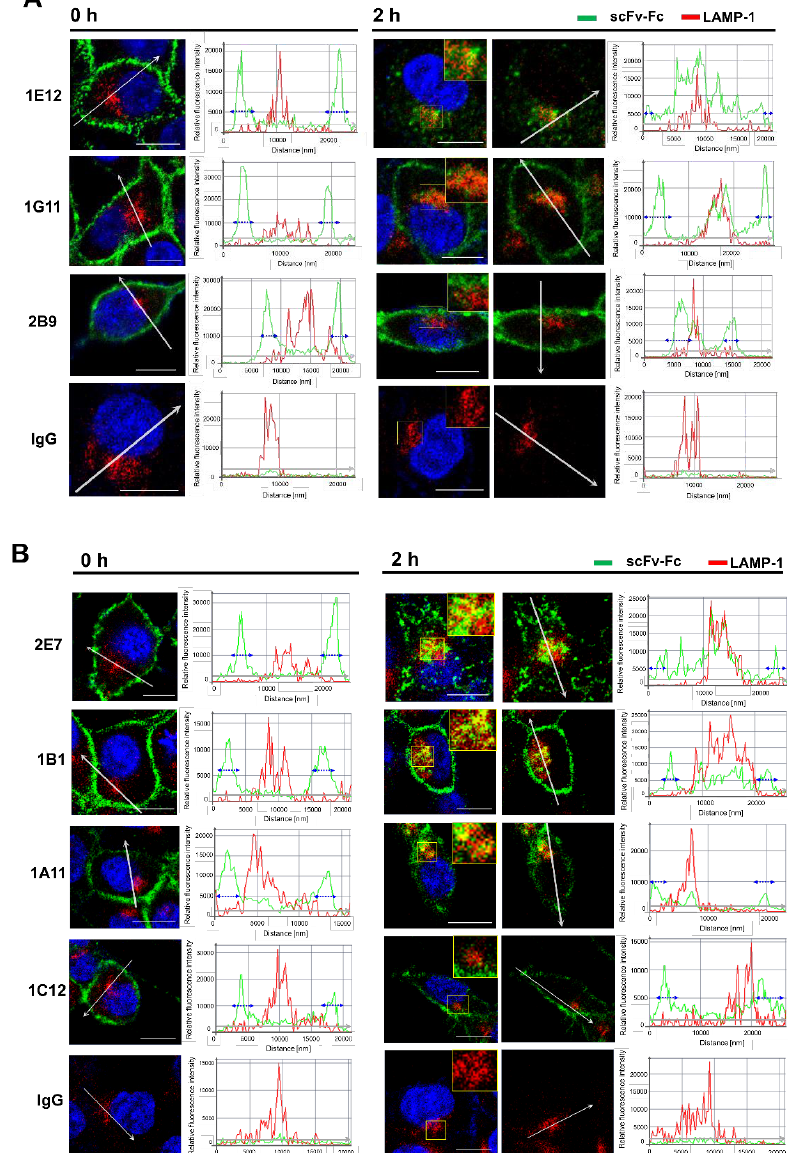
Figure 6. Internalization and subcellular localization of selected scFv-Fcs into MDA-MB-453. Representative images of scFv-Fc for each internalizing group: HIG (1E12 and 2E7), MIG (1B1 and 1A11), and LIG (1G11, 2B9, and 1C12). Representative images of enlarged single cells of ( A ) 1E12, 1G11, and 2B9 scFv-Fc Abs and ( B ) 2E7, 1B1, 1A11, and 1C12 scFv-Fc Abs were incubated with the cells, and the internalized scFv-Fc Abs at 0 h (100% of control) and 2 h at 37 °C were analyzed by confocal fluorescence microscopy (see Materials and Methods). Shown are the merged images of scFv-Fc Abs (green), lysosome marker, LAMP-1 (red), and nuclei (blue). The yellow boxed region of the merged image was magnified for the co-localization of scFv-Fc Abs with the lysosome marker. Arbitrary lines were drawn across the single confocal section of interest. The fluorescence intensities along the drawn line were plotted for scFv-Fc and LAMP-1. Overlapping fluorescent intensity from scFv-Fc and LAMP-1 indicates the co-localization. The blue double-headed arrows in each intensity plot indicates the cell membrane area along the drawn line across the single cell to demonstrate the boundary between the external and the internal area of the cell. See Figure S6 for the representative zoomed-out images of stained cells from which the single-cell images were extracted. All images were observed with Zeiss LSM 880 confocal microscope with objective 40 × ; scale bar, 10 µ